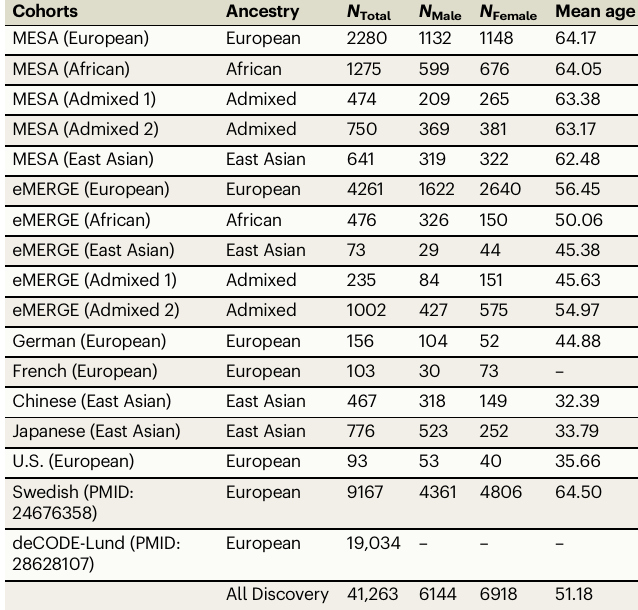
Table 1 | Baseline characteristics of participants in the GWAS cohorts